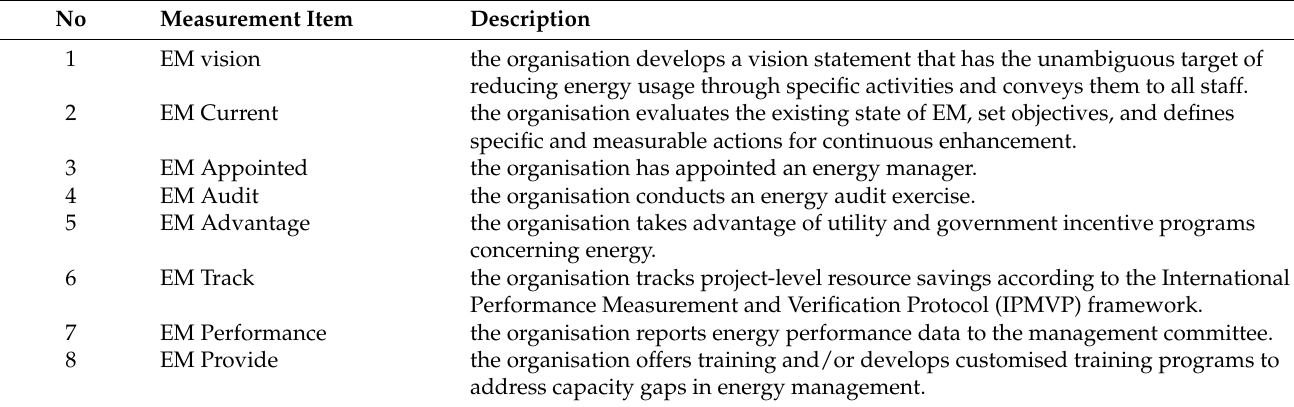
Table 1. Energy management